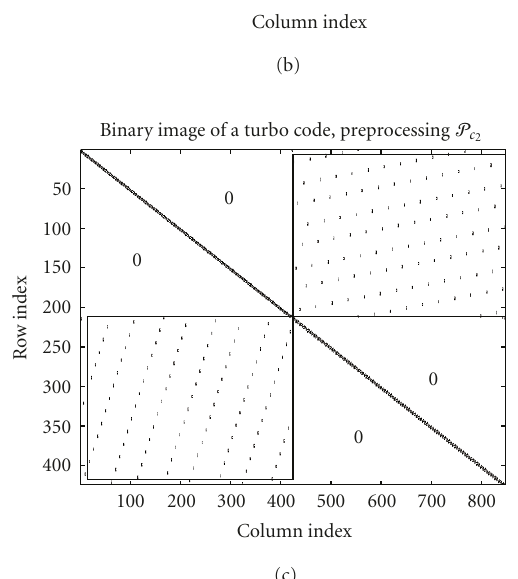
Figure 4: Three di ff erent binary representations of the same rate R = 1 / 3 turbo code. The first one is the natural representation (see , and the third (6)), the second one corresponds to the clustering P c 1 one to the clustering P c 2